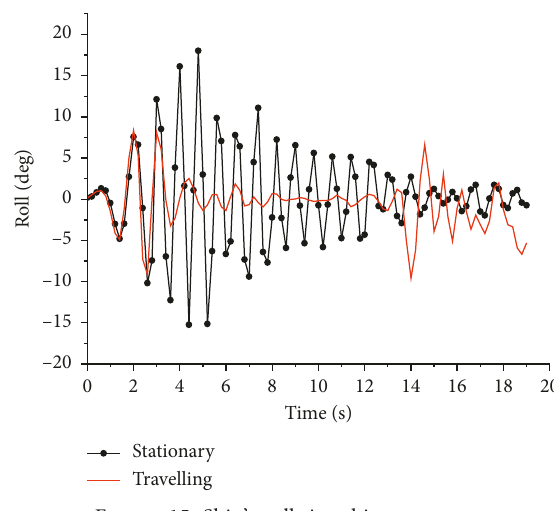
Figure 15: Ship’s roll time-history